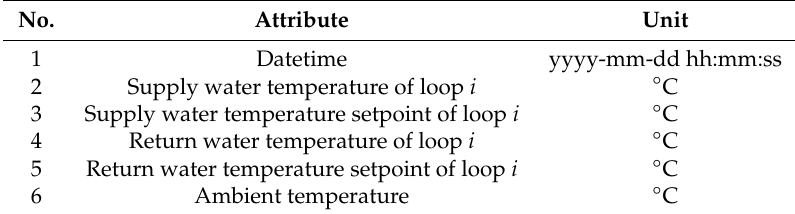
Table 3. The measured attributes of data on the secondary